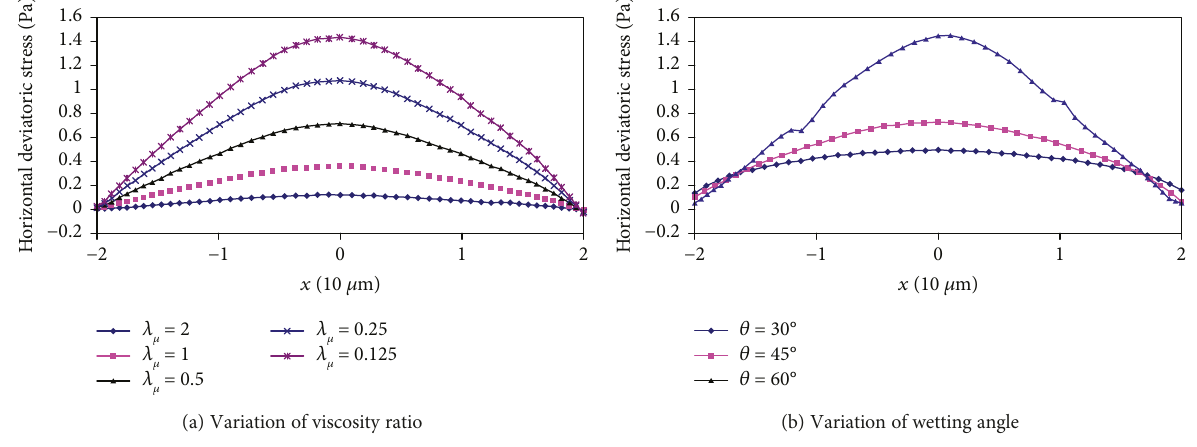
Figure 9: Curves of horizontal deviatoric stress